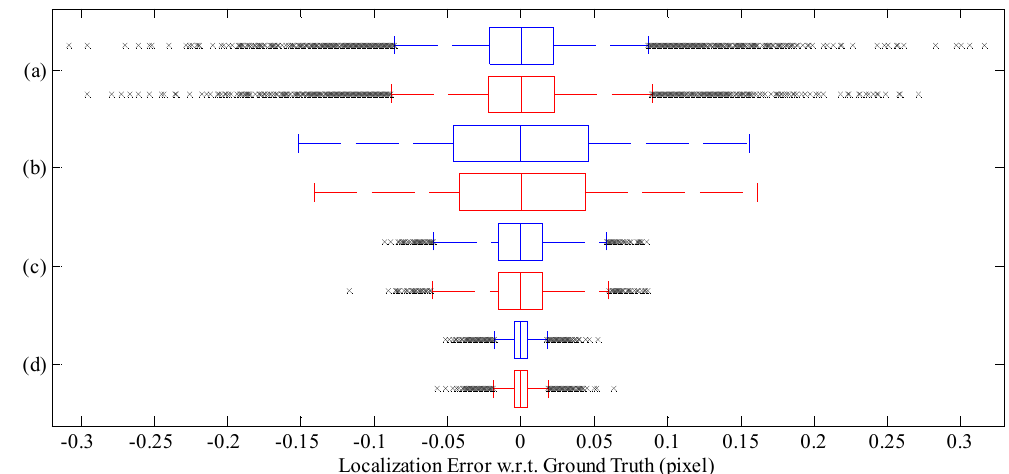
Figure 6. Localization error with respect to blur strength σ f and noise level σ n for ( a ) [16], ( b ) [20], ( c ) [24], and ( d ) the proposed technique.